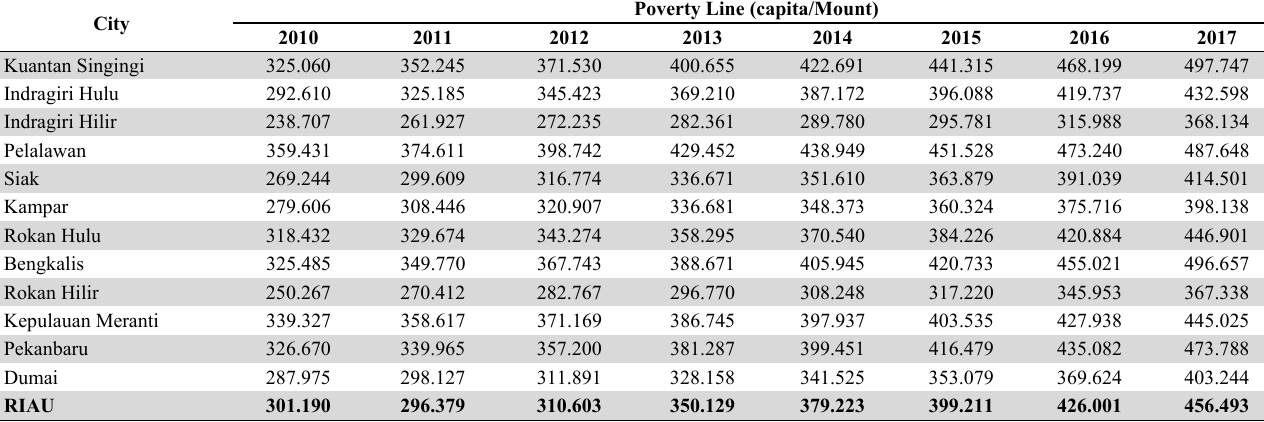
The poverty line in Riau Province during the 2010-2017 City